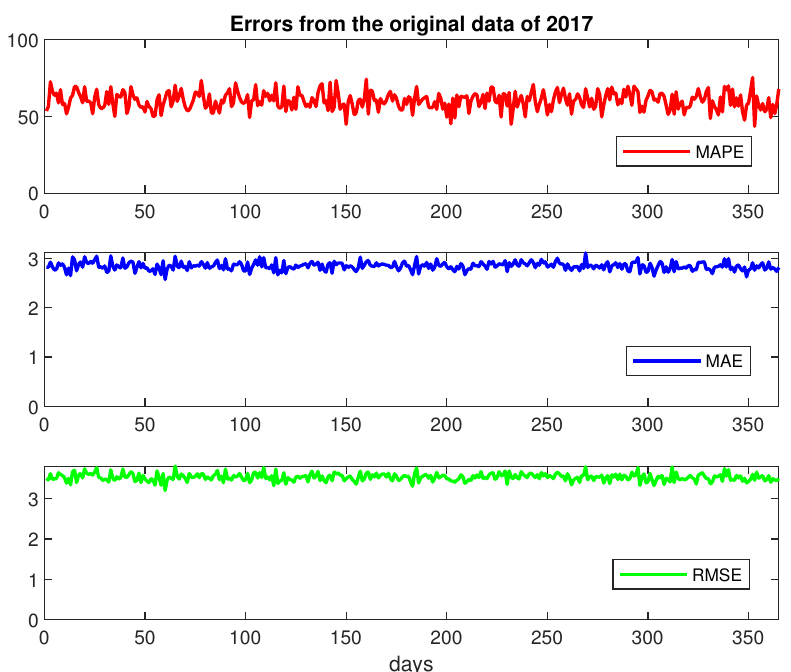
Figure 9. Daily errors of simulated data when compared to observed 2017 temperatures (mean absolute percentage error (MAPE), mean absolute error (MAE), and root mean square error (RMSE)).